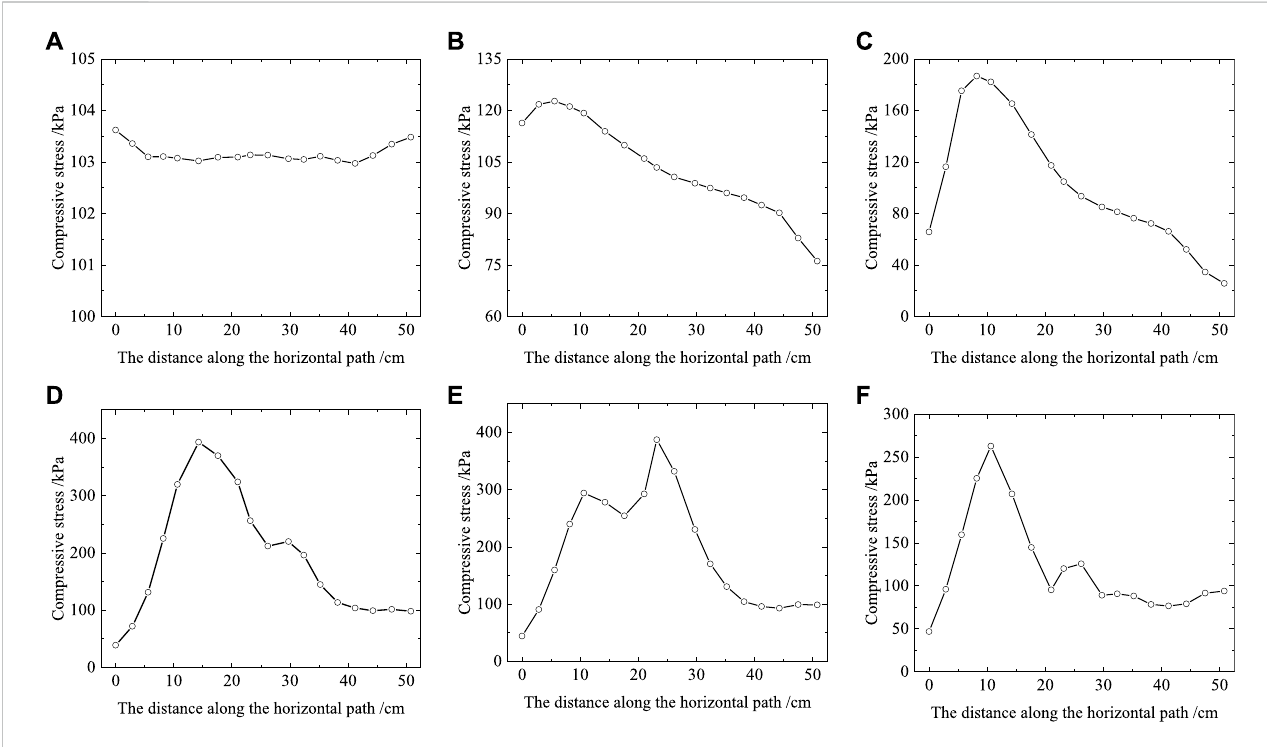
FIGURE 17 The distribution of compressive stress along the horizontal path with different shear displacements ( σ n =100 kPa) (A) w s =0 mm, (B) w s =0.08 mm, (C) w s =0.61 mm, (D) w s =35.5 mm, (E) w s =48.9 mm, and (F) w s =80